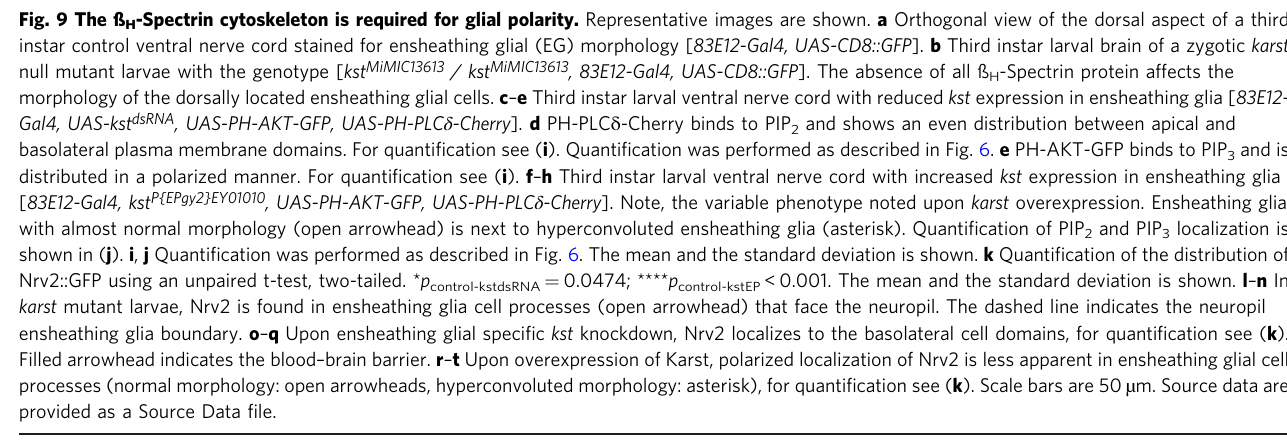
Fig. 9 The ß H -Spectrin cytoskeleton is required for glial polarity. Representative images are shown. a Orthogonal view of the dorsal aspect of a third instar control ventral nerve cord stained for ensheathing glial (EG) morphology [ 83E12-Gal4, UAS-CD8::GFP ]. b Third instar larval brain of a zygotic karst null mutant larvae with the genotype [ kst MiMIC13613 / kst MiMIC13613 , 83E12-Gal4, UAS-CD8::GFP ]. The absence of all ß H -Spectrin protein affects the morphology of the dorsally located ensheathing glial cells. c – e Third instar larval ventral nerve cord with reduced kst expression in ensheathing glia [ 83E12- Gal4, UAS-kst dsRNA , UAS-PH-AKT-GFP, UAS-PH-PLC δ -Cherry ]. d PH-PLC δ -Cherry binds to PIP 2 and shows an even distribution between apical and basolateral plasma membrane domains. For quanti fi cation see ( i ). Quanti fi cation was performed as described in Fig. 6. e PH-AKT-GFP binds to PIP 3 and is distributed in a polarized manner. For quanti fi cation see ( i ). f – h Third instar larval ventral nerve cord with increased kst expression in ensheathing glia [ 83E12-Gal4, kst P{EPgy2}EY01010 , UAS-PH-AKT-GFP, UAS-PH-PLC δ -Cherry ]. Note, the variable phenotype noted upon karst overexpression. Ensheathing